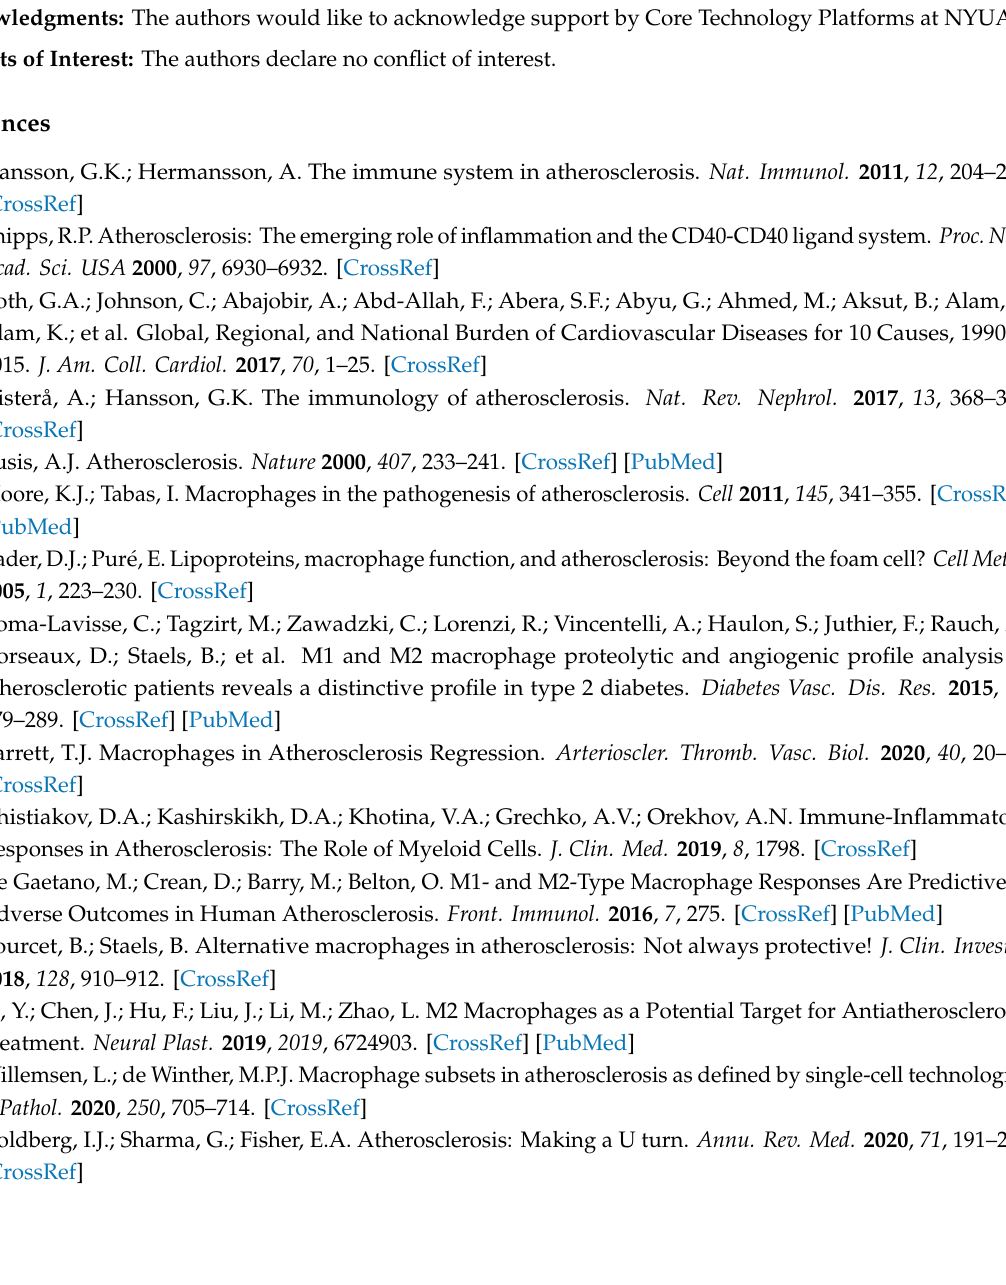
Figure S1: Fluorescence assisted cell sorting assessment of LDL uptake by monocytes and macrophages cultured in 3D collagen hydrogels. Table S1: Primer